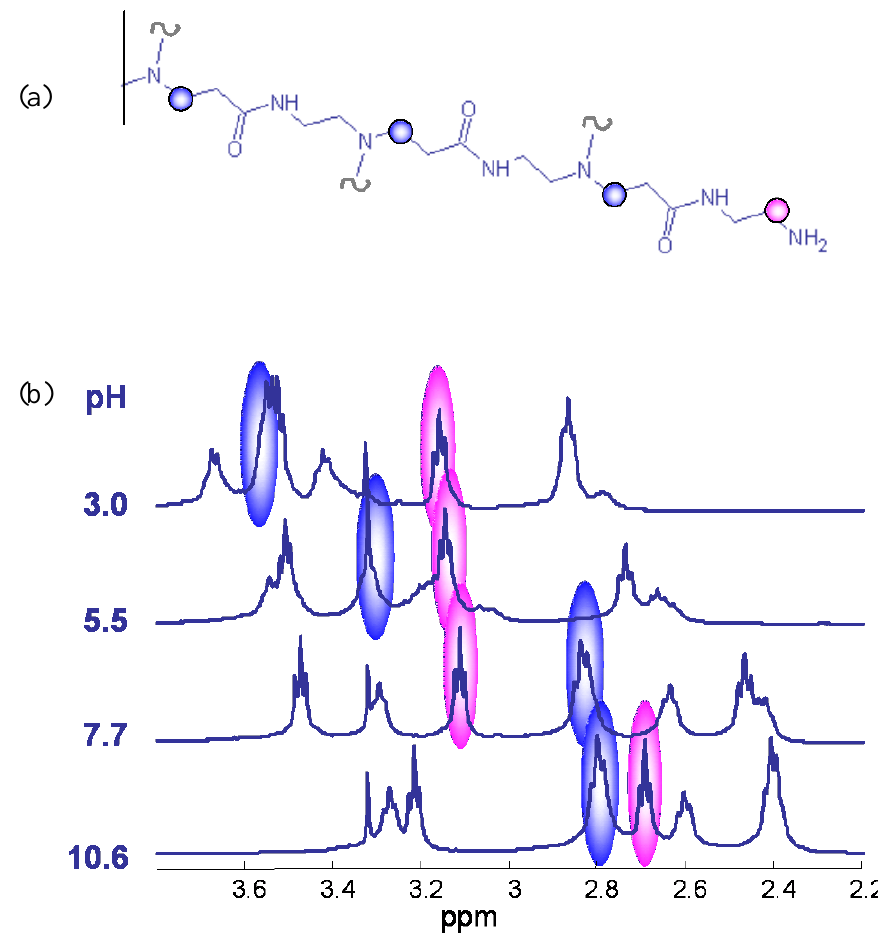
Figure 1. (a) Branch of a PAMAM dendrimer of generation 2. The methylene groups next to the terminal primary amino groups are labeled in pink and next to the interior tertiary amino groups are labeled with blue color. (b) 1 H NMR spectra of PAMAM G2 at different pH values showing the chemical shift of the selected methylene groups as function of pH with a label of the same color as in